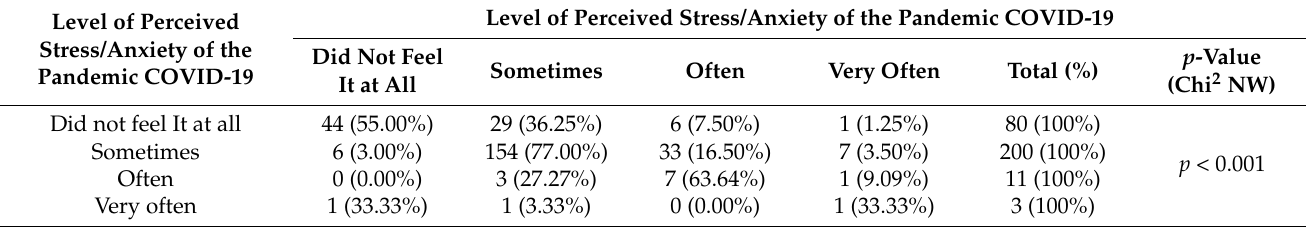
Table 8. Level of perceived stress/anxiety before and during the pandemic COVID-19.